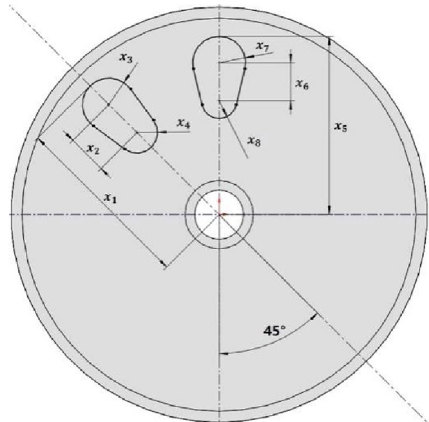
Figure 21 Structural parameters of lightening holes in a mining hoist sheave